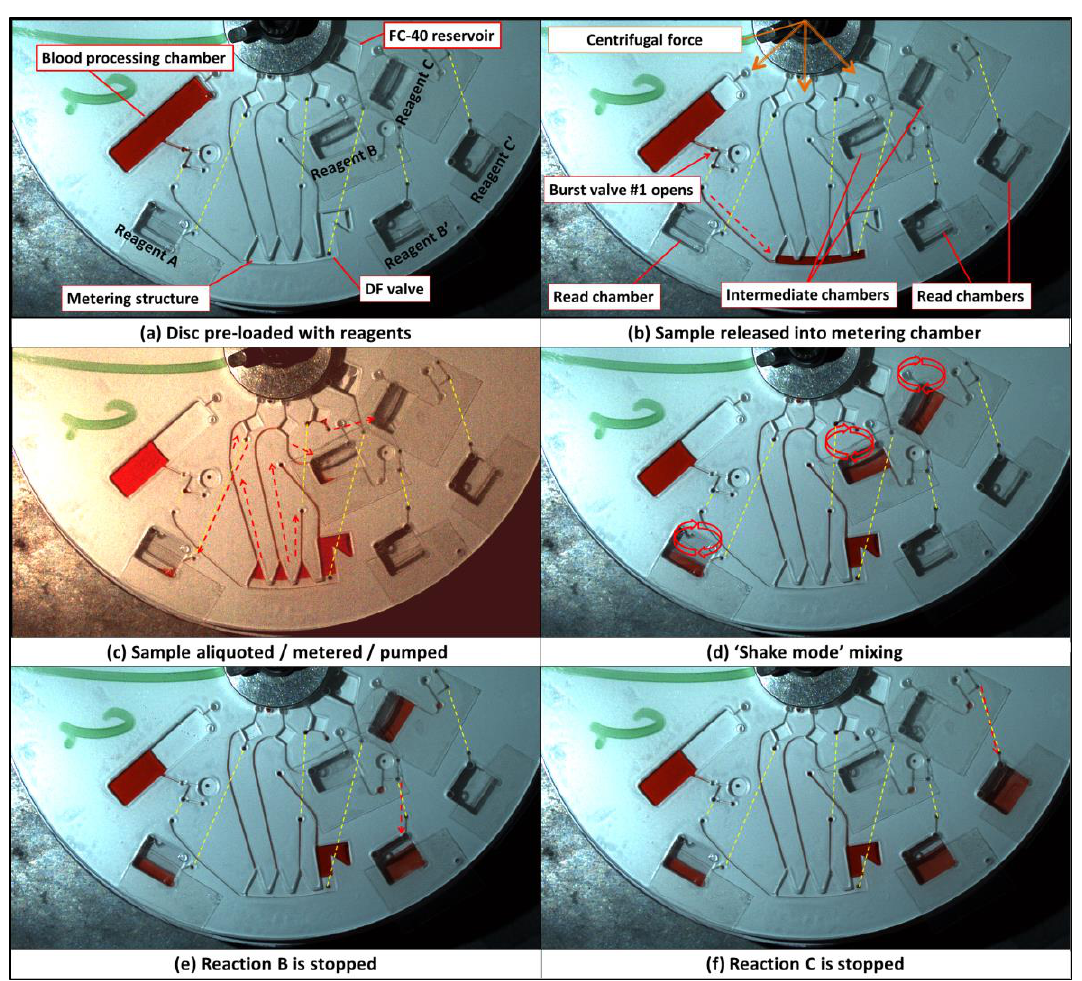
Figure 8. Disc designed for integrated bio-assays using integrated metering/mixing/pumping. ( a ) The disc is pre-loaded with FC-40 as the pumping liquid, clear (DI) water and dyed water to represent the bio-reagents, and working sample (blood/plasma), respectively. Connecting channels on the underside of the disc are shown by dashed yellow lines. ( b ) Increasing the spin rate to 30 Hz (Figure 7b) releases dyed water into the metering structure. ( c ) The DF located in the metering struc- ture opens to release the FC-40. The sample is aliquoted, accurately metered, and pumped radially inwards. ( d ) The sample is added to Reagents A, B, and C and mixed using the rotational ‘shake mode’ -induced Euler force. ( e ) After 3 min, the spin rate is increased to 45 Hz and plasma/Reagent B solution is released into the read chamber where it mixes with the ‘stop reagent’ Reagent B’. ( f ) Similarly, after a further 12 min, the spin rate is increased to 55 Hz and the plasma/Reagent C solu- tion is mixed with Reagent C’. Note that the disc shown in this figure has an identical function but a slightly different architecture (location of waste collection chamber; size of read chambers) com- pared to the disc shown in Video S5 (the disc in Video S5 was used to generate the results described in Section 4). This structure can accurately aliquot and meter samples and then deliver them to distant locations on the disc. Rather than using a conventional metering structure, which often uses valves with significant dead volumes, the outlet from this structure is a micro- channel of a minimal cross-section (0.5 × 0.086 mm 2, as manufactured using the methods described here). If extended across the entire 120 mm diameter of a typical disc, this mi- crochannel has a maximum dead volume of ~5 µL. Additionally, unlike conventional DF- valving technologies, metering using open microchannels is compatible with all non- aqueous liquids [41]. 4. Liver Assay Panel